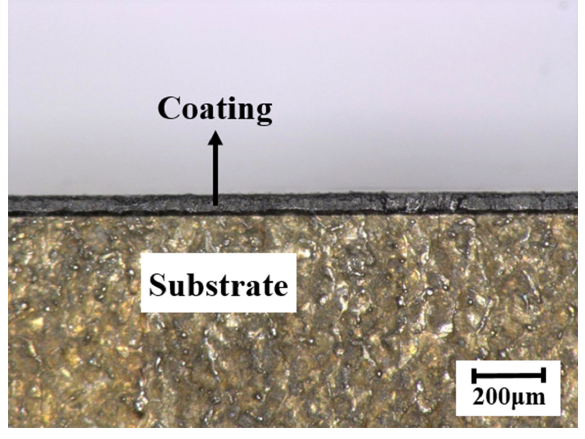
Figure 4: Microscope image of a cross-section of the EP/CNF-MoS 2